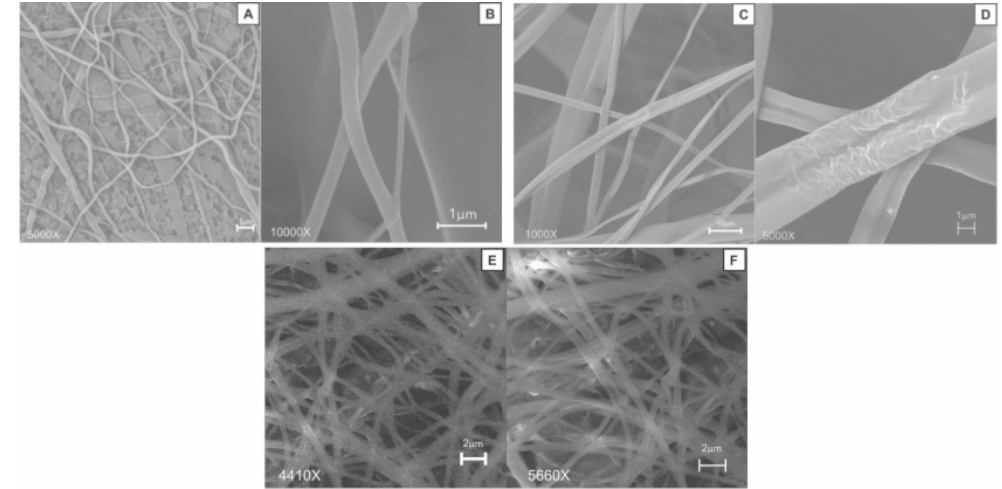
Figure 2. SEM micrographs of the fibers obtained using different electrospinning conditions (Table 1). Electrospinning conditions 1 ( A , B ), 2 ( C , D ), and 3 ( E , F ). Magnifications 5000× and 10,000×.